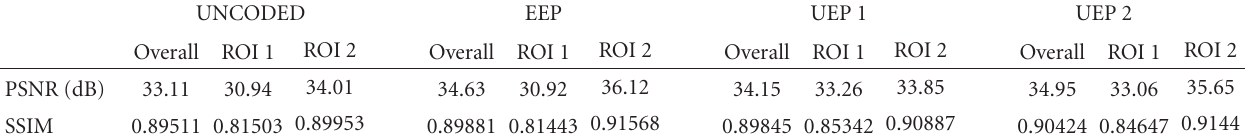
Table 7: Video quality results.